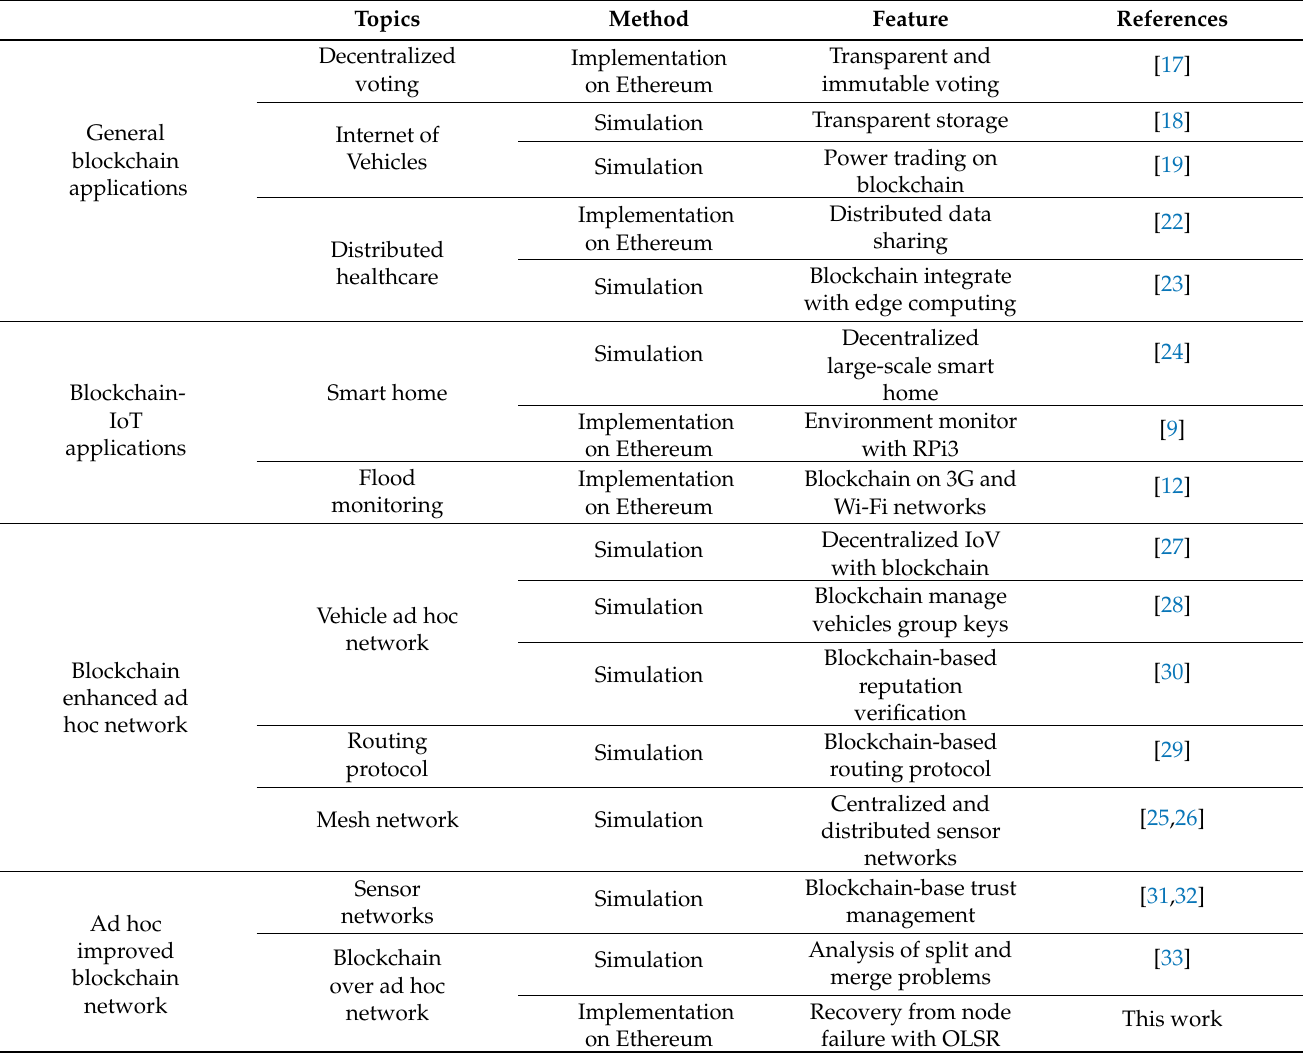
Table 1. Overview of the related works and